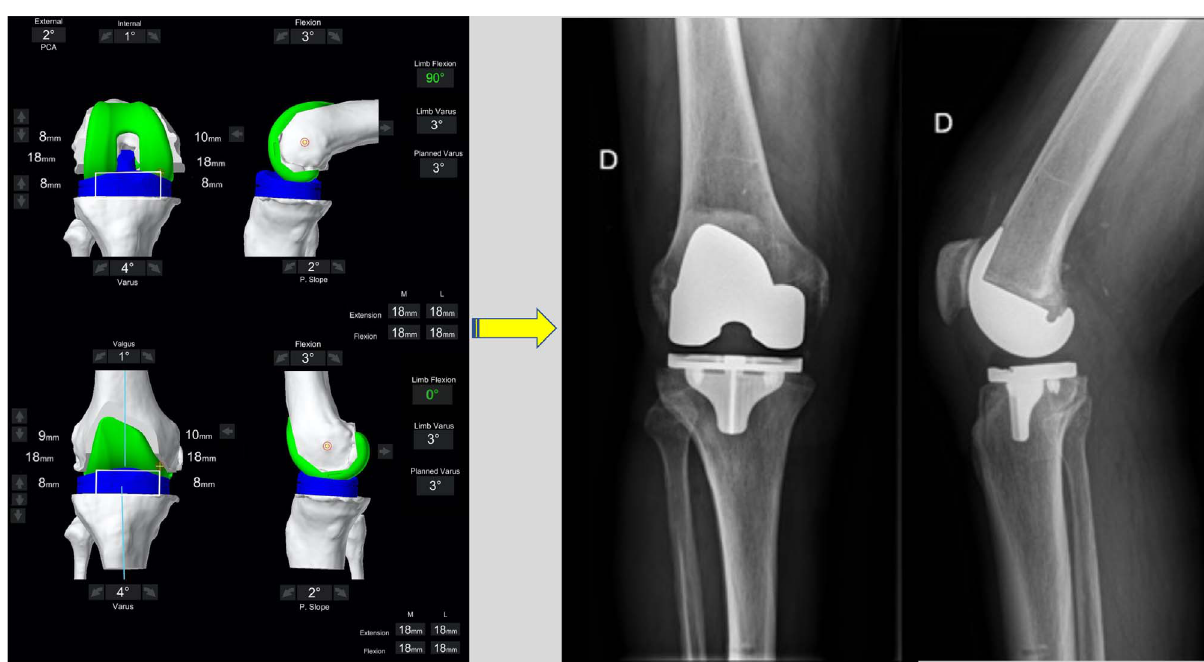
Figure 6. The fi nal intra-operative position. Limb alignment, resections depth, and tibiofemoral gaps in fl exion and extension are shown. The achieved coronal alignment is 177 (cid:1) or 3 (cid:1) varus, and the sagittal alignment is 0 (cid:1) of fl exion. The post-operative X-ray at 3 months follow-up of the same patient is